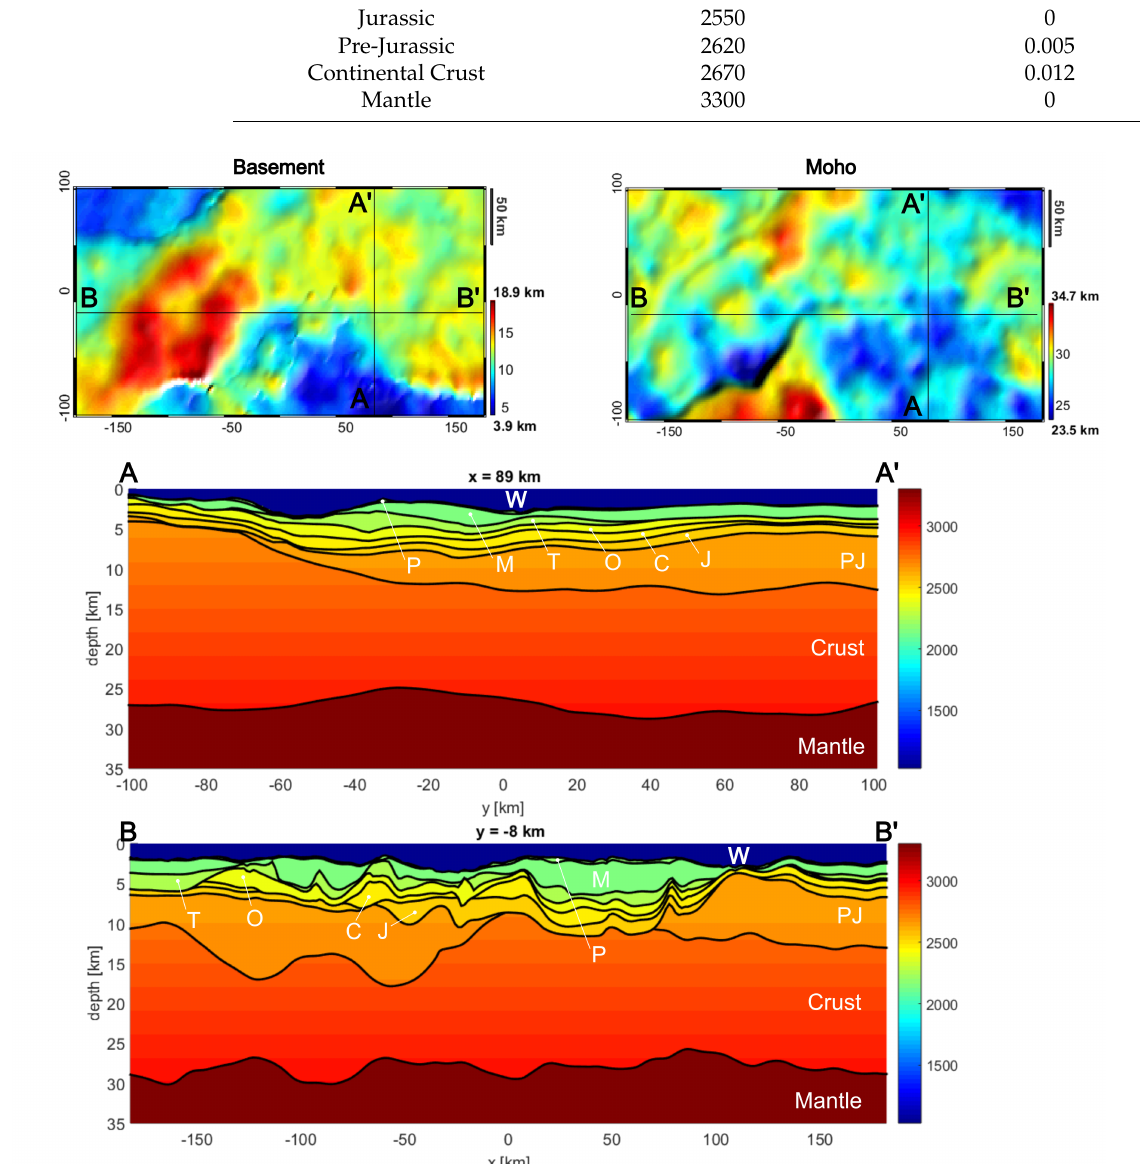
Figure 1. Depth to basement and Moho depth of the synthetic model (upper images). Example of two profiles (AA’ and BB’) on the synthetic 3D model. Solid black lines represent discontinuity between different geological units, colours represent density in kg/m 3 . W stands for oceanic water, P Plio-Quaternary sediments, M Messinian salt, T Tortonian sediments, O Oligocene sediments, C Cretaceous sediments, J Jurassic sediemnts, PJ Pre-Jurassic